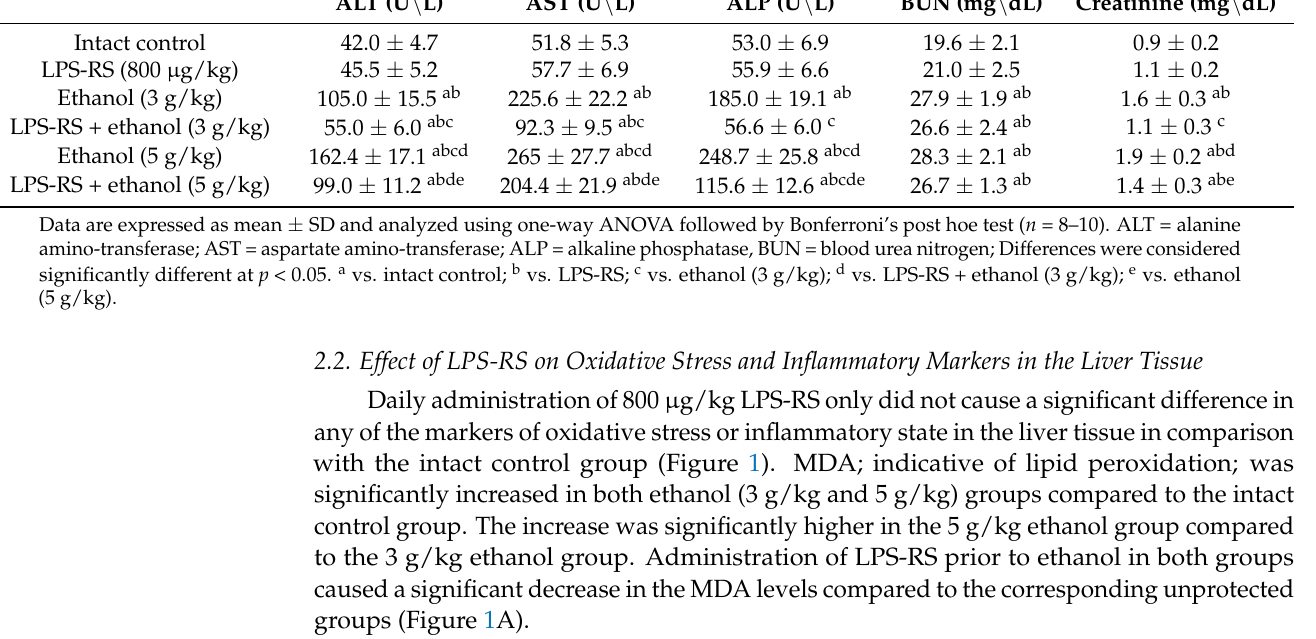
Table 1. The effect of LPS-RS (800 μg/kg) on serum levels of liver enzymes and kidney function markers in the experi- mental rats.